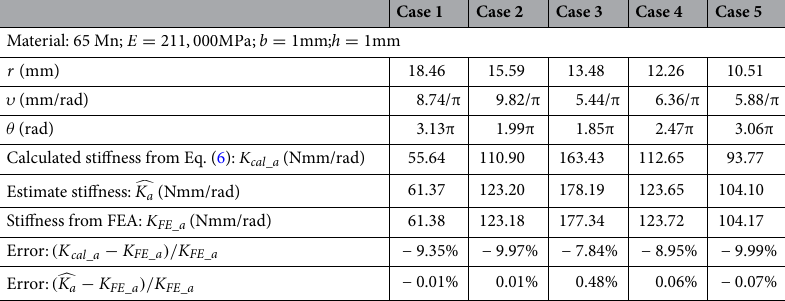
Table 2. Parameters and stiffness comparison of spring arms.